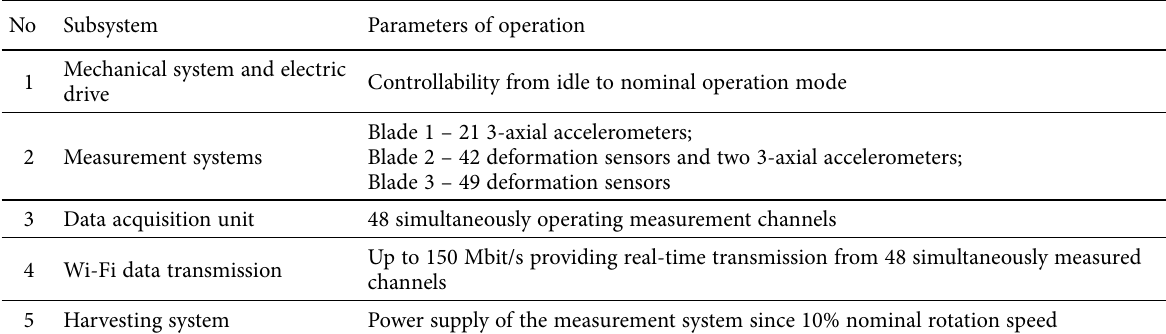
Table 2. Parameters of the experimental system operation No